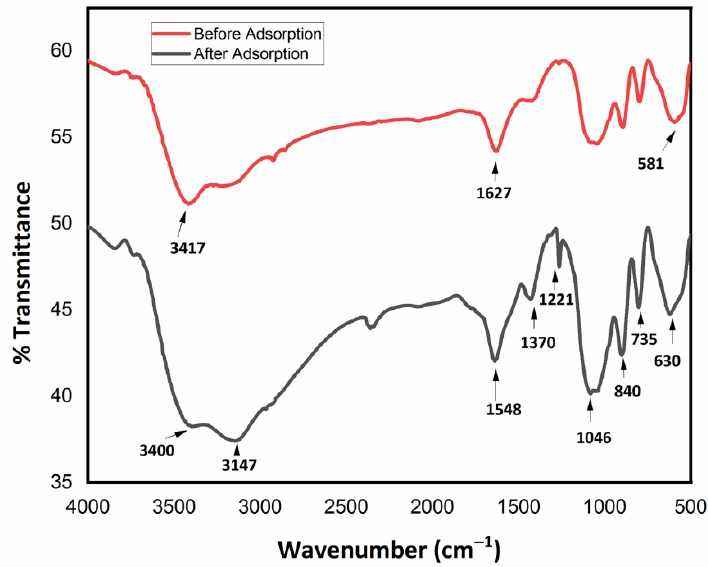
Figure 6. FTIR spectra of Fe 3 O 4 NHS before and after its application on TNT wastewater for required adsorption.